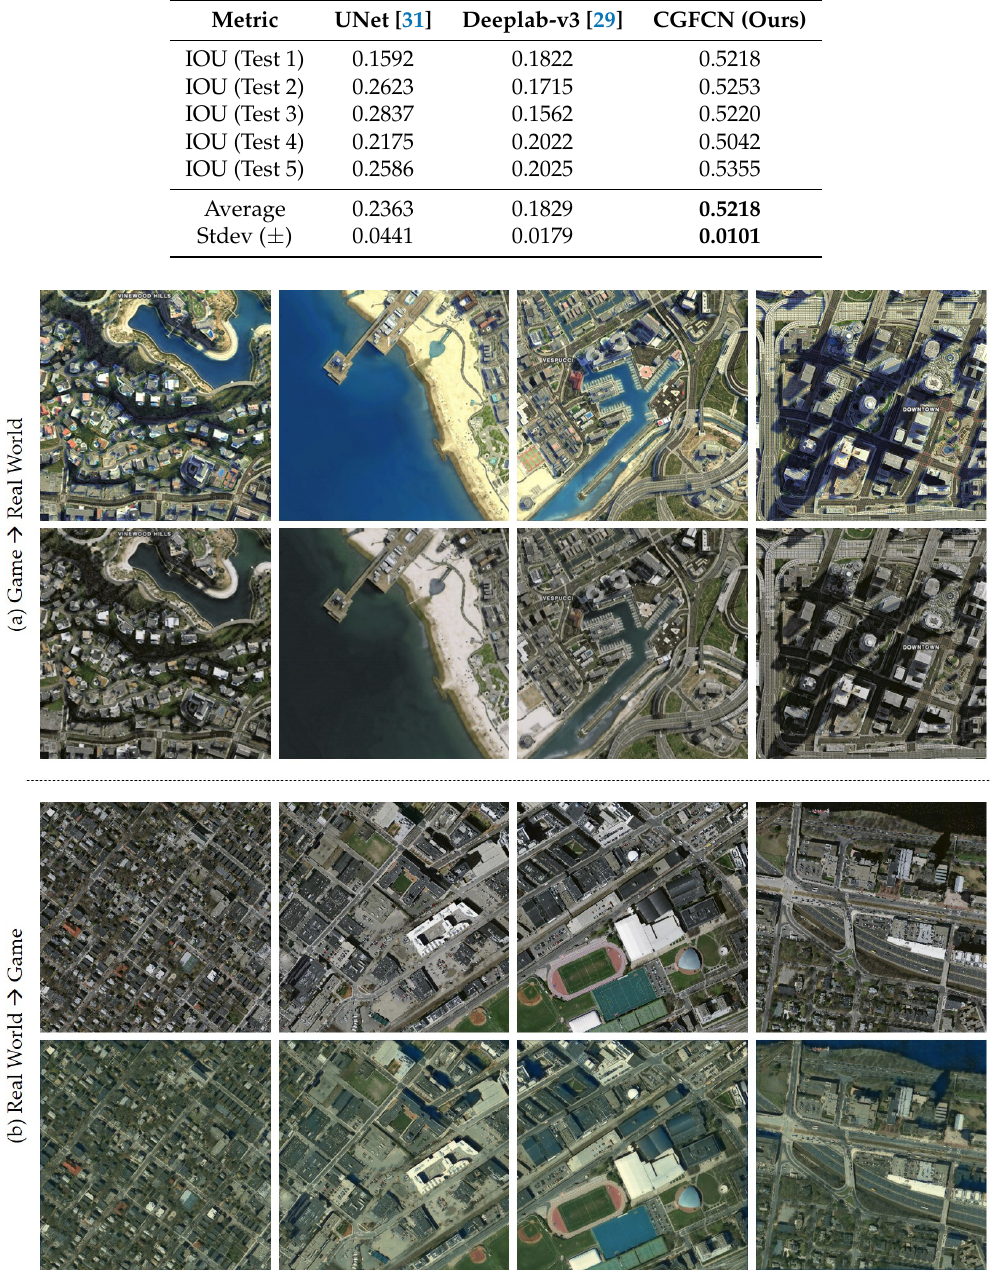
Figure 4. (Better viewed in color) Some image translation results from using our method. ( a ) The first two rows show the translation results from the game domain to the real-world domain. ( b ) The last two rows show the inverse translation results from the real-world domain to the game